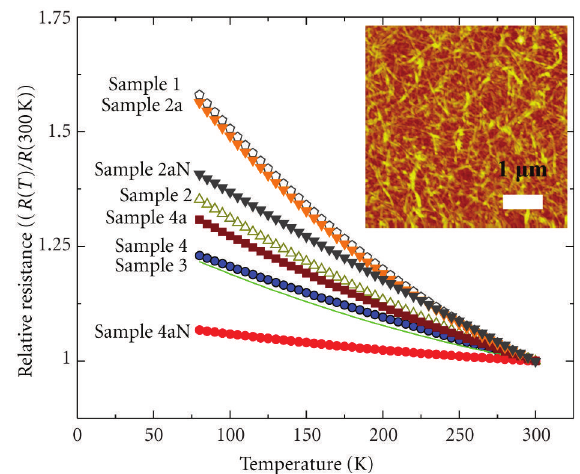
Figure 1: The change of relative resistance (R(T)/R(300K)) with temperature for samples 1–4aN at temperature of 78–300 K. Inset shows an AFM image of a typical SWCNT